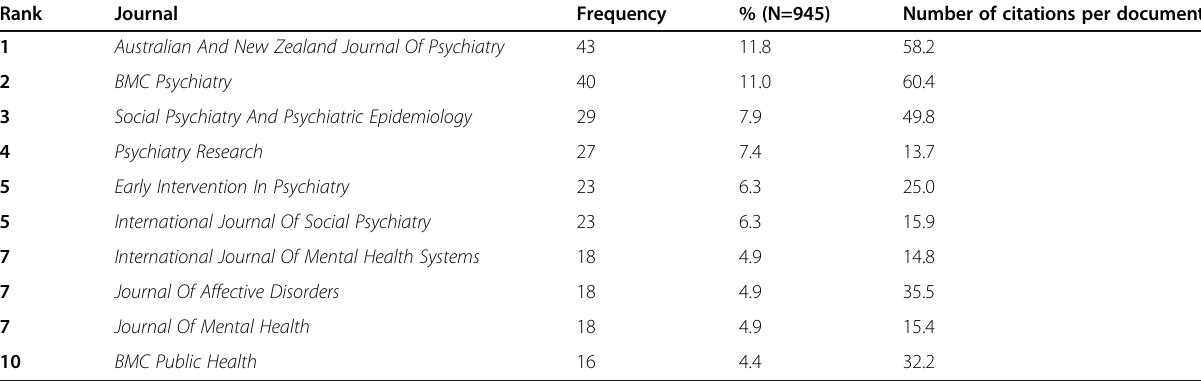
Table 3 Top ten active journals in publishing research documents on mental health literacy